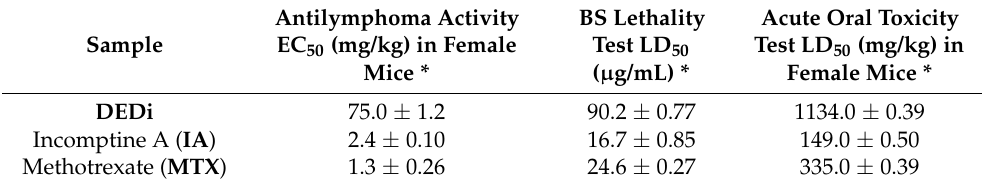
Table 1. Antilymphoma, lethality, and toxic activities of incomptine A ( IA ) and the dichloromethane extract of the aerial parts from D. incompta